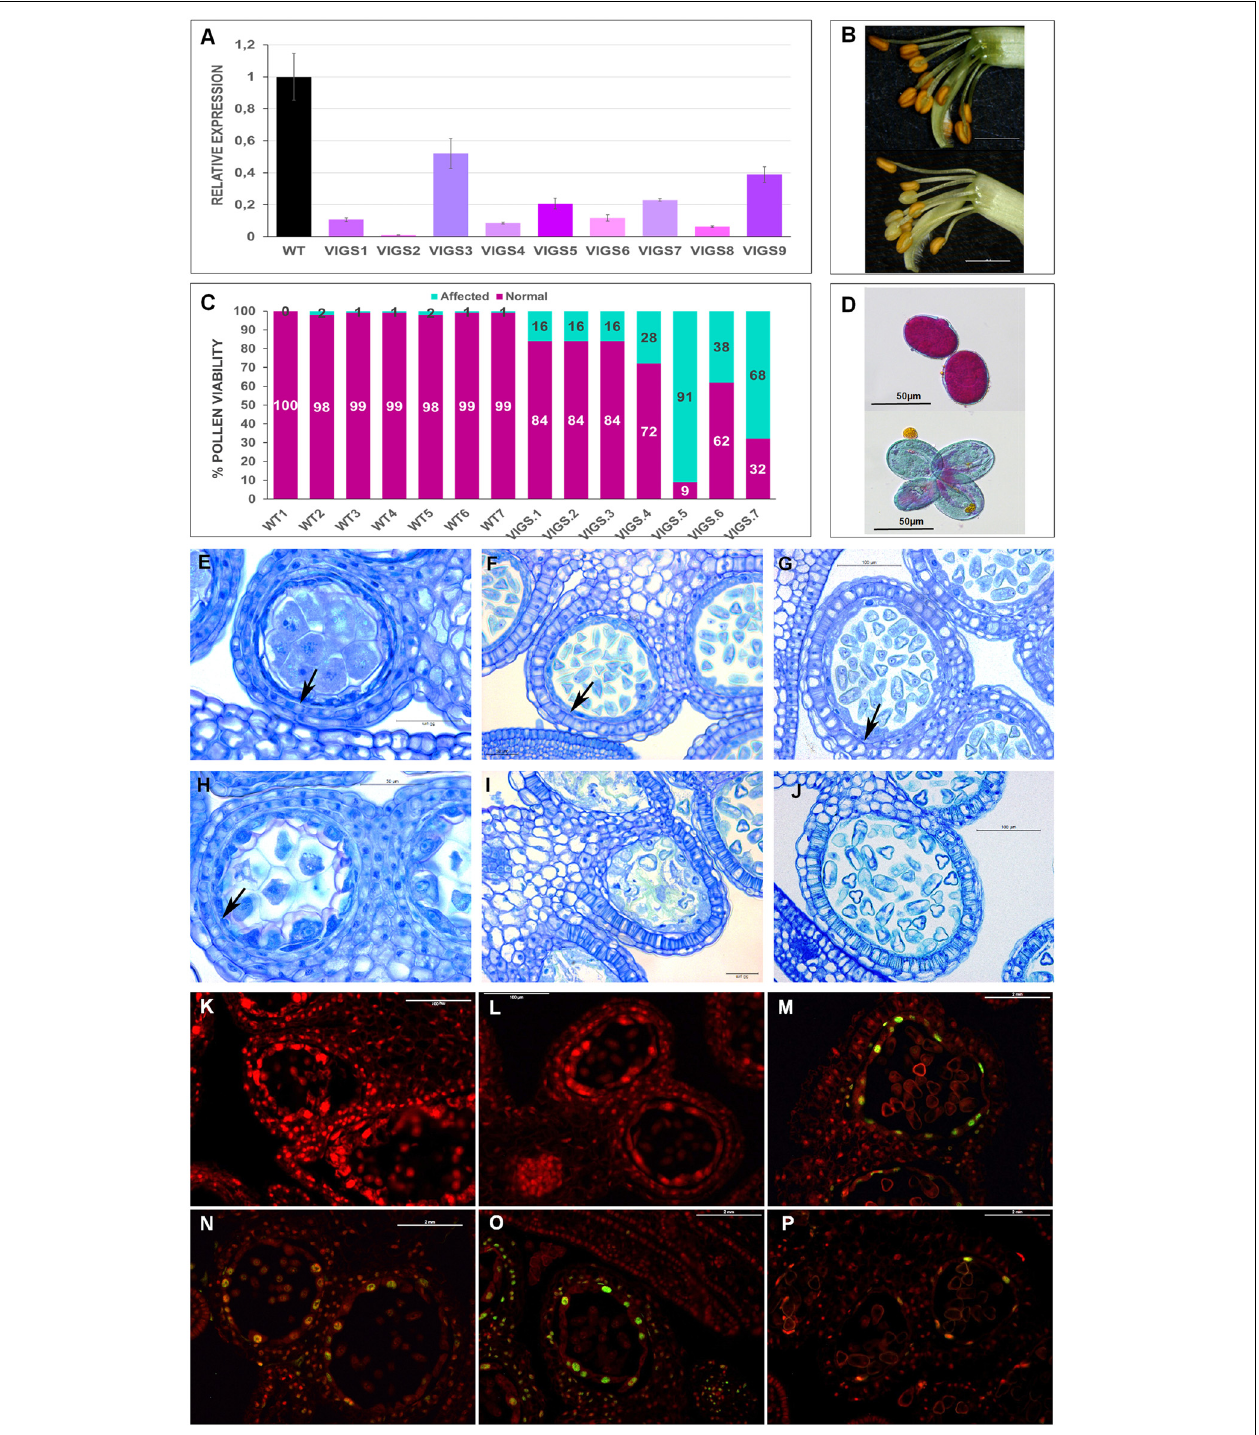
FIGURE 3 | Phenotypic characterization of VIGS- PsEND1 pea flowers. (A) Expression of PsEND1 in flower buds of different VIGS plants. (B) Detail of the stamens of wild type (upper) and VIGS- PsEND1 (bottom) plants. The anthers of the VIGS- PsEND1 plants showed a white color and small size. (C) Percentage of viable pollen in the wild type and VIGS- PsEND1 plants. (D) Alexander’s staining of pollen; wild type (upper) and VIGS plant (bottom). Viable pollen protoplasm is stained pink, while dead pollen is stained blue. Histological sections of wild type (E–G) and VIGS- PsEND1 (H–J) pea flowers. (E,H) 3 mm flowers, (F,I) 5 mm flowers, (G,J) 7 mm flowers. Arrows in (E–H) indicate the presence of tapetal cells. Scale bars in (E–J) correspond to 100 µ m. (K–P) Detection of DNA fragmentation by TUNEL assays of pea anthers of the wild type (K–M) and VIGS- PsEND1 anthers (N–P) . Cell wall or membranes showed red fluorescence and the positive apoptotic nuclei stained with TUNEL were deep